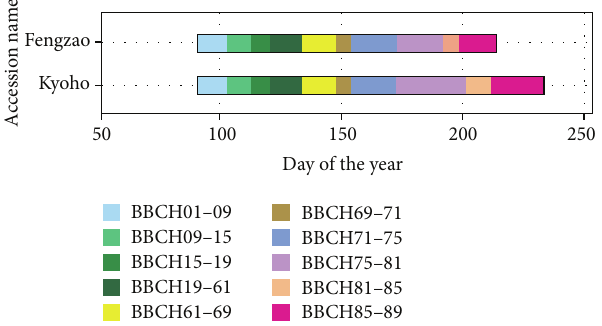
Figure 1: Phenological variance between “Fengzao” and “Kyoho.” The color changes represent different growing stages according to Rustioni et al.